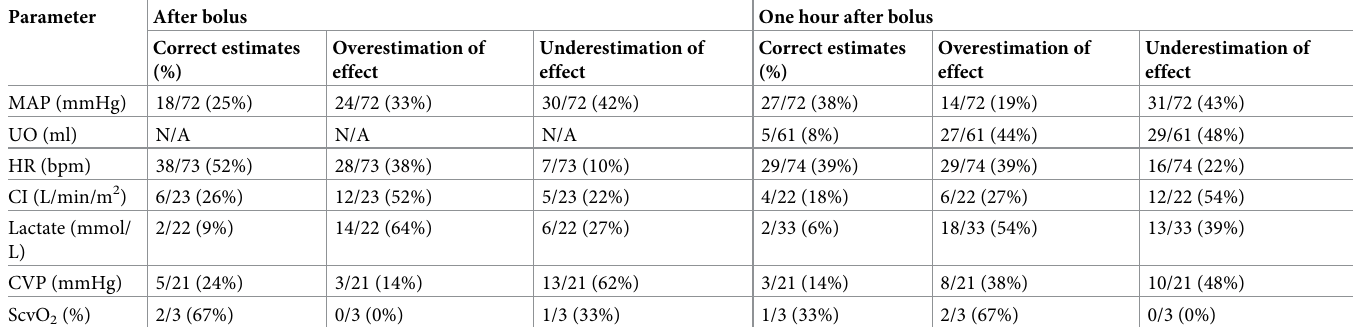
Figs in S1 Appendix. All show limited correlation. Bland-Altman plots of bias and limits of agreement, between measured and expected MAP and HR after FB and after one hour as well as UO after one hour are displayed in S4–S8 Figs in S1 Appendix. Table 2. Accuracy of